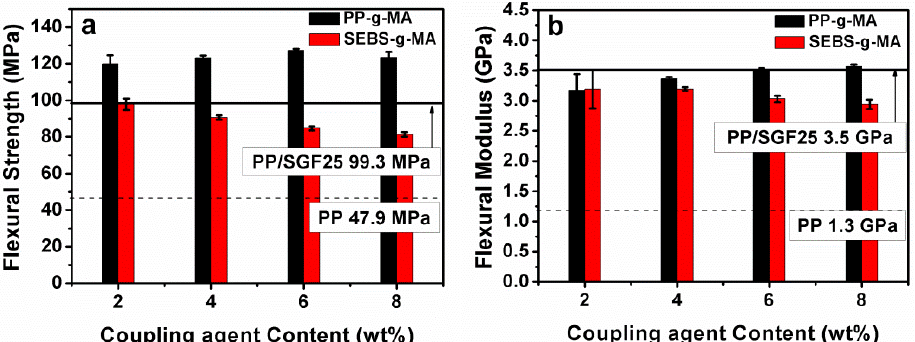
Figure 2. ( a ) Flexural strength and ( b ) flexural modulus of PP/SGF composites.